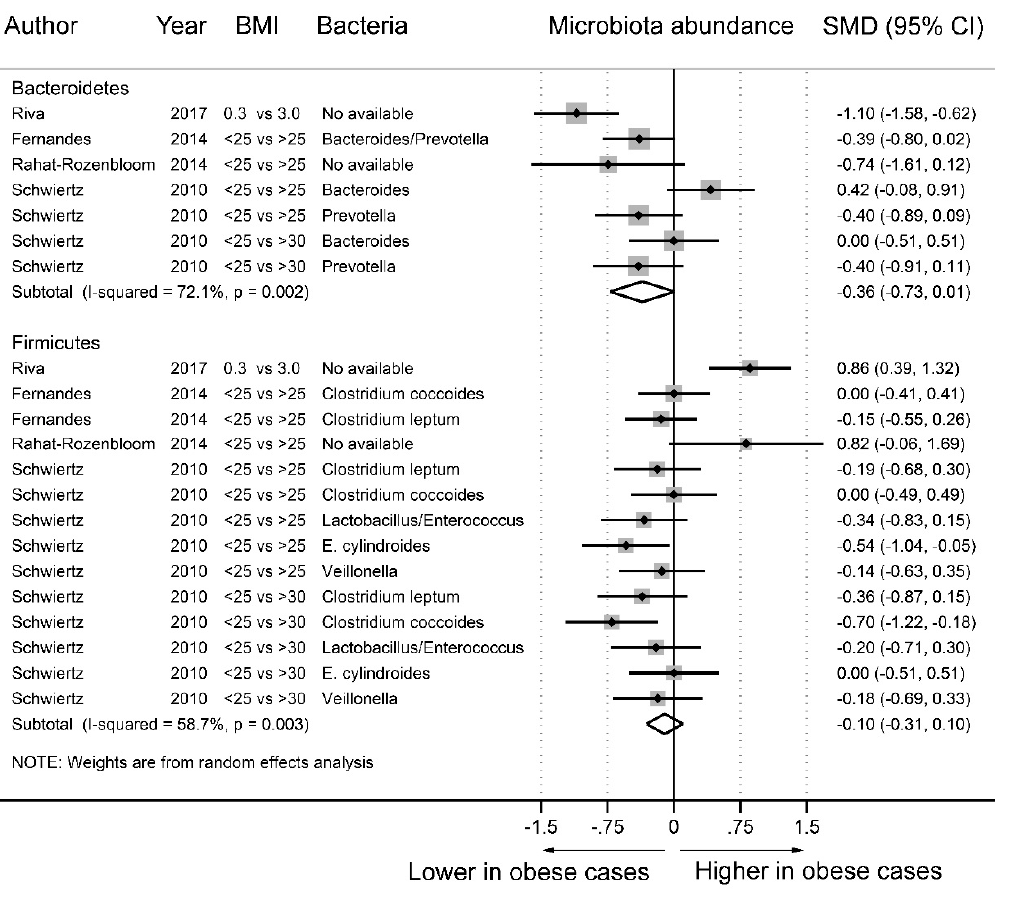
Figure 5. Forest plots of studies of fecal microbiota abundance at the phylum level in obese and nonobese individuals. The combined standardized mean differences (SMD) and 95% confidence intervals (CIs) were calculated using random effects models.